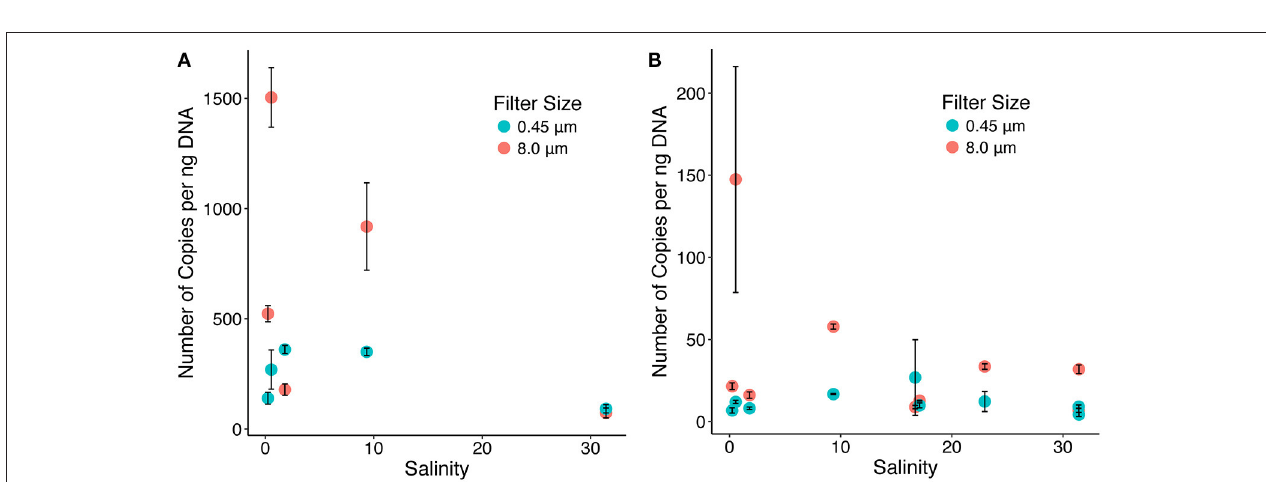
FIGURE 3 | Nutrient (A) and chlorophyll (B) concentrations along the salinity gradient where samples were collected.